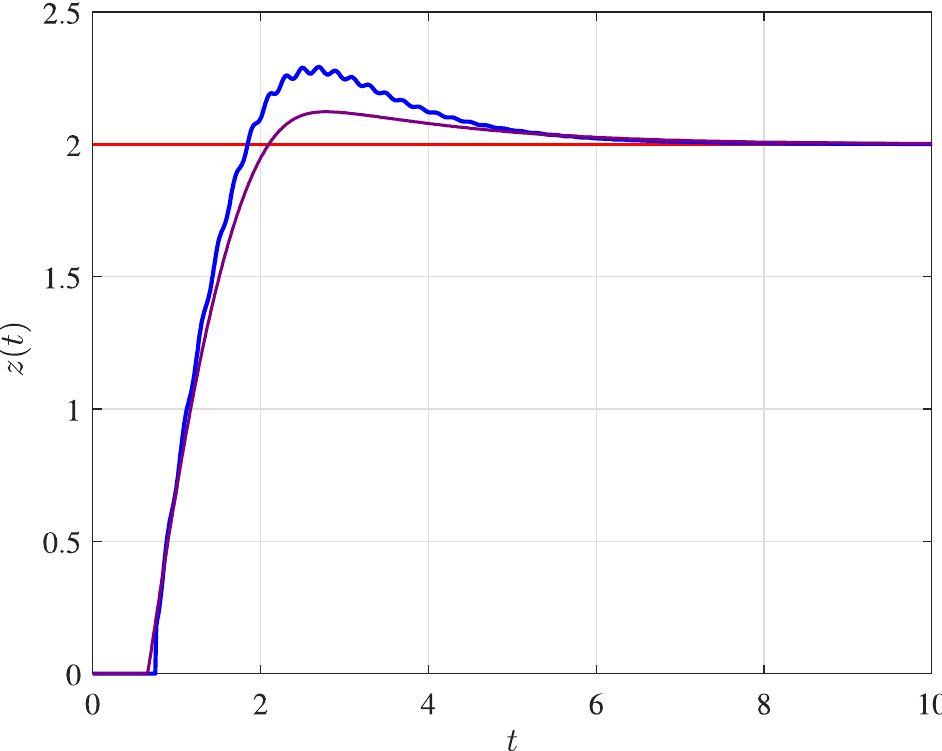
Figure 6. Control input 𝑈 (cid:2869) , showing the elastic (solid blue line) and rigid (solid purple line) attachments. For simplicity, the elastic influence is shown only in the vertical direction; however, it also extends to the horizontal positions and the attitude angles. Figure 7 shows the roll angles, considering both the elastic and rigid attachment configurations. The undesired